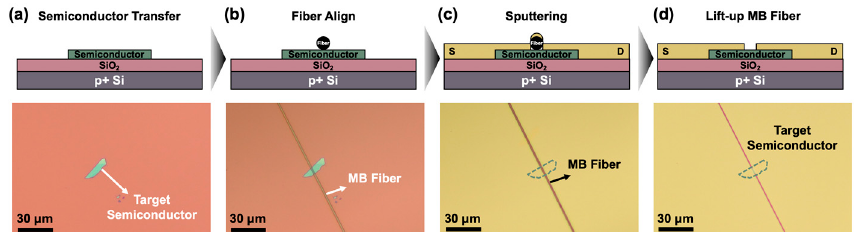
Figure 1. The non-lithographic micro-scaled device fabrication flow steps; ( a ) 2D transition-metal- dichalcogenides (TMDC) transferring on the silicon substrate; ( b ) melt-blown (MB) fiber alignment on the target TMDC nanoflake; ( c ) metal sputtering; ( d ) lifting-up MB fiber for S / D electrodes formation.